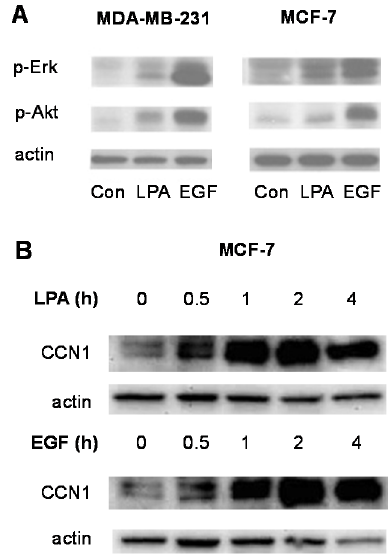
Figure 2. Effects of LPA and EGF on signal transduction events in human breast cancer cells. ( A ) Serum ‐ starved MCF ‐ 7 and MDA ‐ MB ‐ 231 cells were incubated with 10 μ M LPA or 10 nM EGF for 5 min. Whole ‐ cell extracts were immunoblotted using antibodies recognizing phosphorylated active Erk and Akt. An immunoblot for total actin was performed as a loading control; ( B ) Serum ‐ starved MCF ‐ 7 cells were incubated for the indicated times with 10 μ M LPA or 10 nM EGF. Whole ‐ cell extracts were immunoblotted using antibody recognizing total CCN1. An immunoblot for total actin was performed as a loading control. Each experiment is representative of at least three separate experiments.